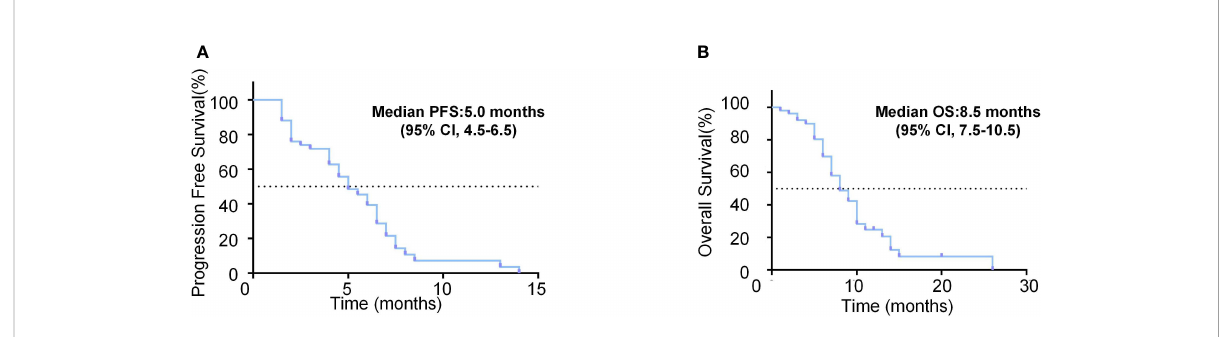
FIGURE 3 Survival analysis of unresectable HCC patients treated with lenvatinib as the second-line treatment. (A) Kaplan-Meier curves of PFS for the unresectable HCC patients treated with lenvatinib as the second-line treatment. (B) Kaplan-Meier curves of OS for the unresectable HCC patients treated with lenvatinib as the second-line